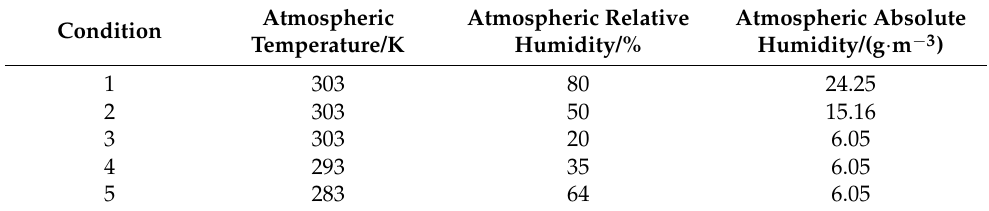
Table 9. Comparison of temperature and water vapor content